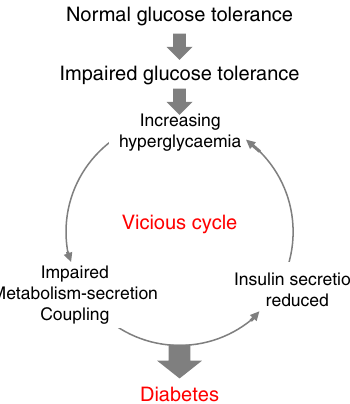
Fig. 10 Schematic showing how a small rise in glucose might lead a vicious cycle that progresses to diabetes by progressively impairing β -cell